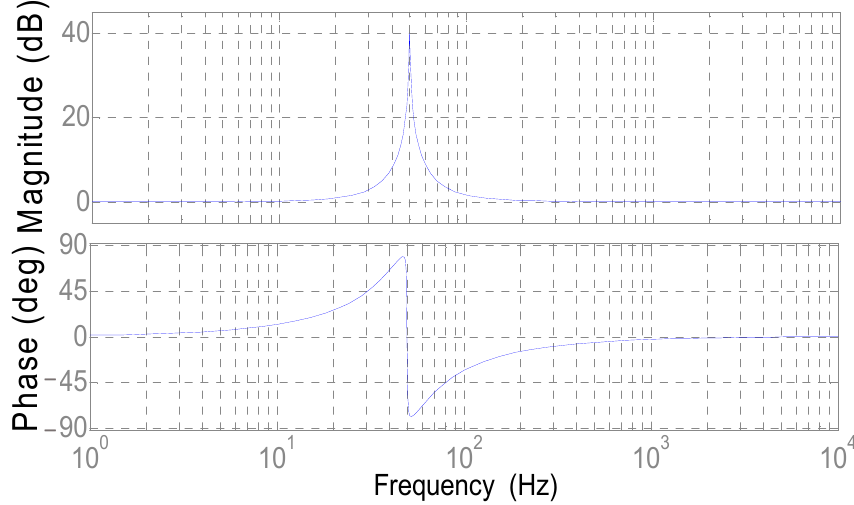
Figure 1. Bode plot of P+R controller with transmittance (Equation (1)). Using Equation (2), a structure consisting of simple blocks (P or I) was obtained. The integral part with integration time T 2 and the proportional part with gain k form the parallel structure of the PI controller. The proposed structure of the P+R controller is shown in Figure 2, where the resonant part of the regulator is highlighted by a dashed line [22].